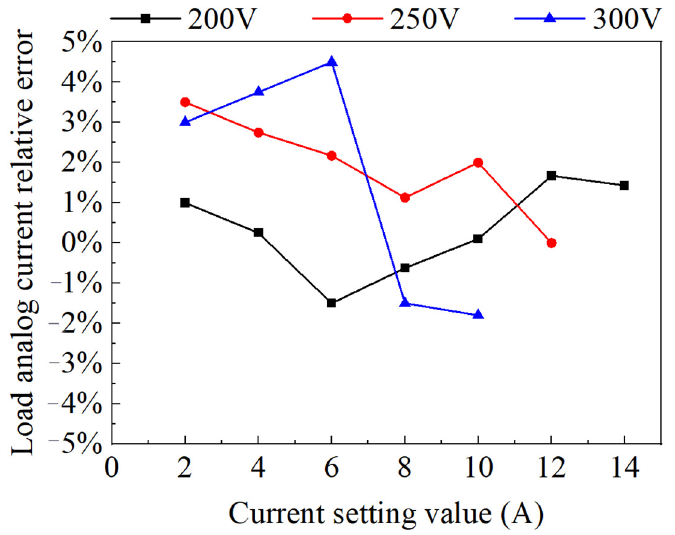
Figure 12. Load simulation current relative error curve.